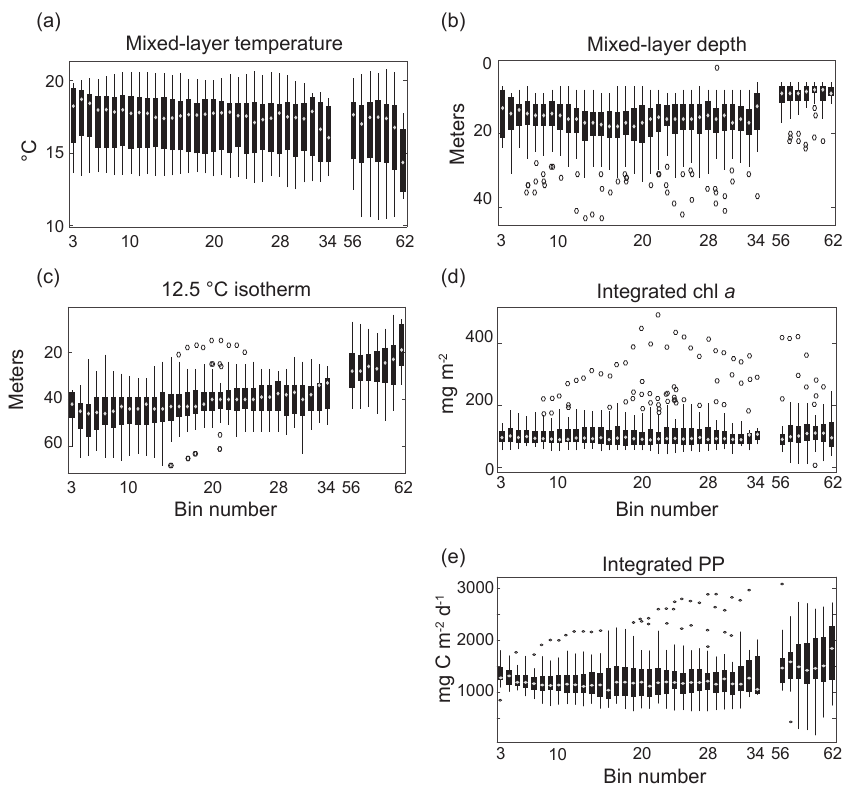
Figure 2. Cross-channel variation in profile characteristics. Cross-channel variation in mixed-layer temperature (a) , mixed-layer depth (b) , the depth of the 12.5 ◦ C isotherm (c) , vertically integrated chlorophyll (surface to 70m, d ), and vertically integrated primary production (surface to euphotic depth) (e) for gridded glider profiles from March through July of 2013 and 2014 are shown. Cross-channel box plots show the median value for each bin (white dot), data between the 25th and 75th percentiles (black box), data between the ninth and 91st percentiles (black lines), and outliers (black circles). Low numbered bins correspond with the western side of the San Pedro Channel (SPC), near Catalina. High numbered bins correspond with the eastern side of the SPC, near the Palos Verdes Peninsula (PV). Bins 35–55 correspond with the shipping lanes for the Port of Los Angeles and so have been removed due to incomplete profiles